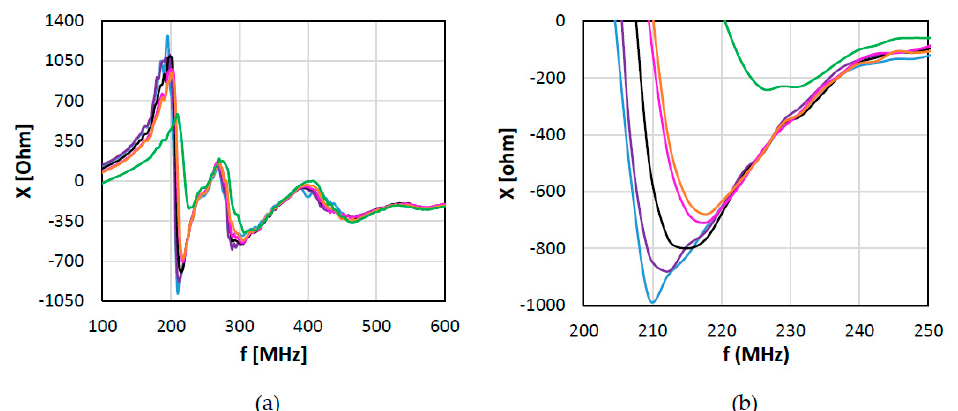
Figure 4. Spectra of X ( a ) and values of the minimum peak in the restricted range considered for the measurements ( b ), for water ( – ), 1-propanol ( – ) and water–ethanol mixtures with ethanol molar fraction of 0.007 ( – ), 0.219, ( – ), 0.495 ( – ), and 0.854 ( – ).